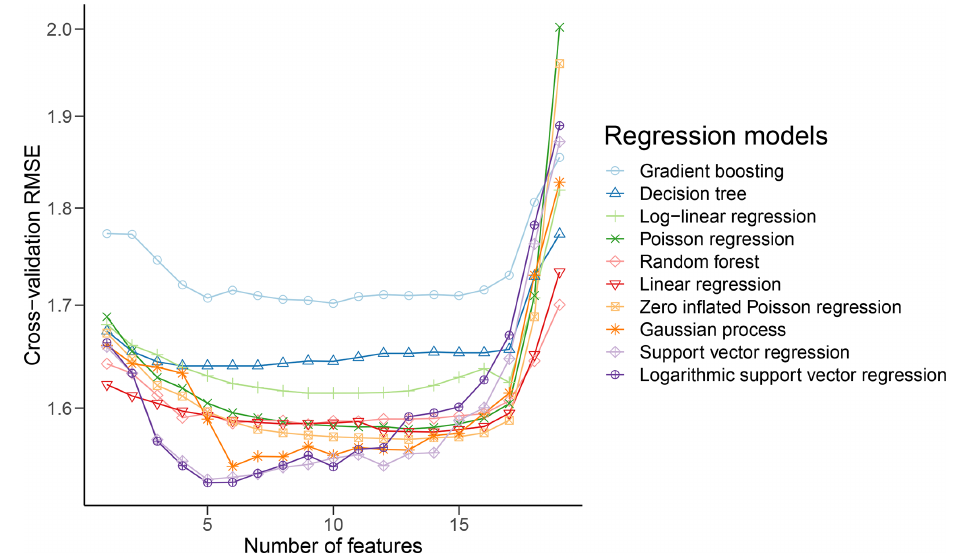
Figure 4. Feature selection results on KU18 for all regression models. Table 3. Comparison of selected models based on KU18. Performance refers to the cross-validated RMSE; number of features refers to the optimal number selected during forward feature selection. Prior use means the model has been used for similar tasks in literature. A “ + ” means better than average, which is not necessarily more than